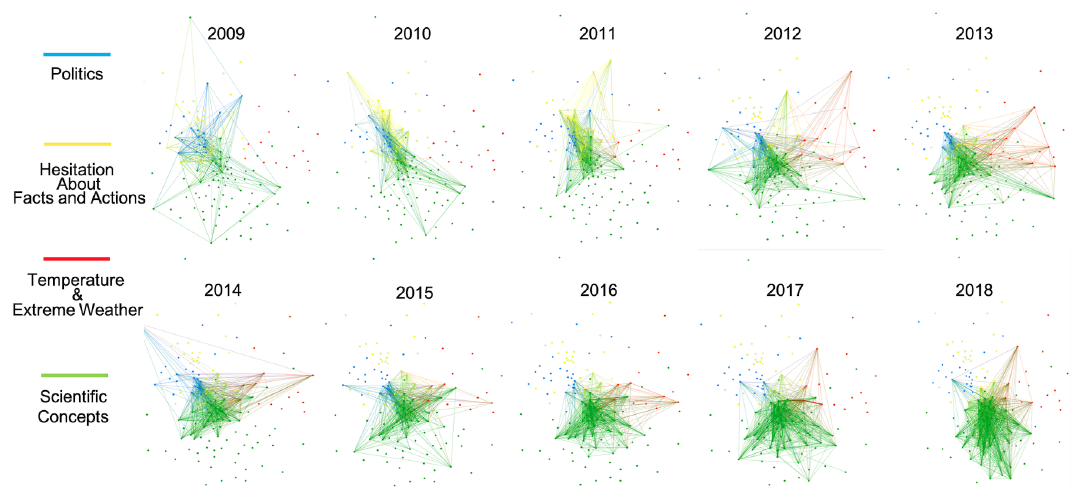
Figure 3. Association network of top 50 nodes of climate change for each year from 2009 to 2018.